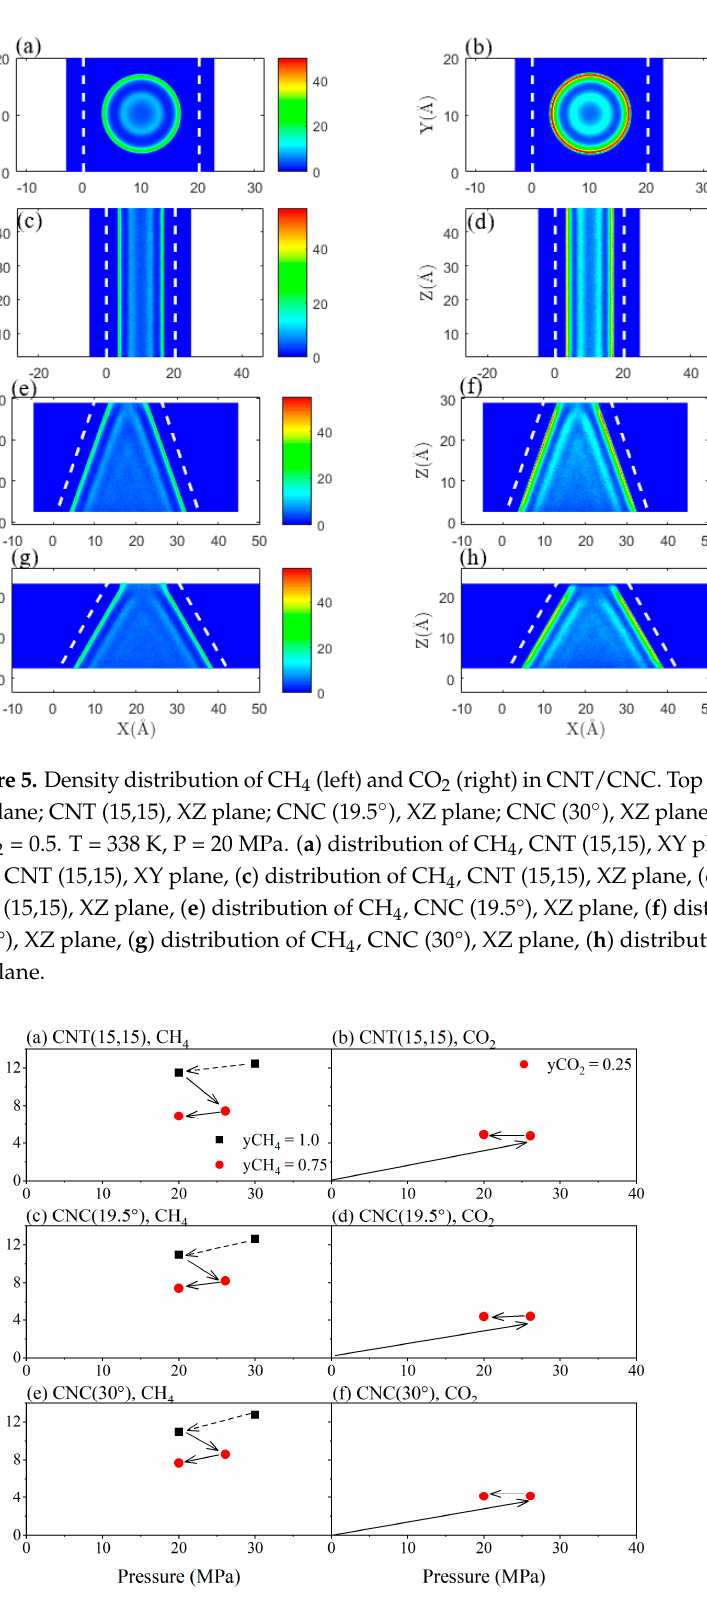
Figure 6. Density evolution of CH 4 (left) and CO 2 (right) in CNT/CNC. Top to bottom: CNT (15,15), CNC (19.5°), and CNC (30°). T = 338 K.